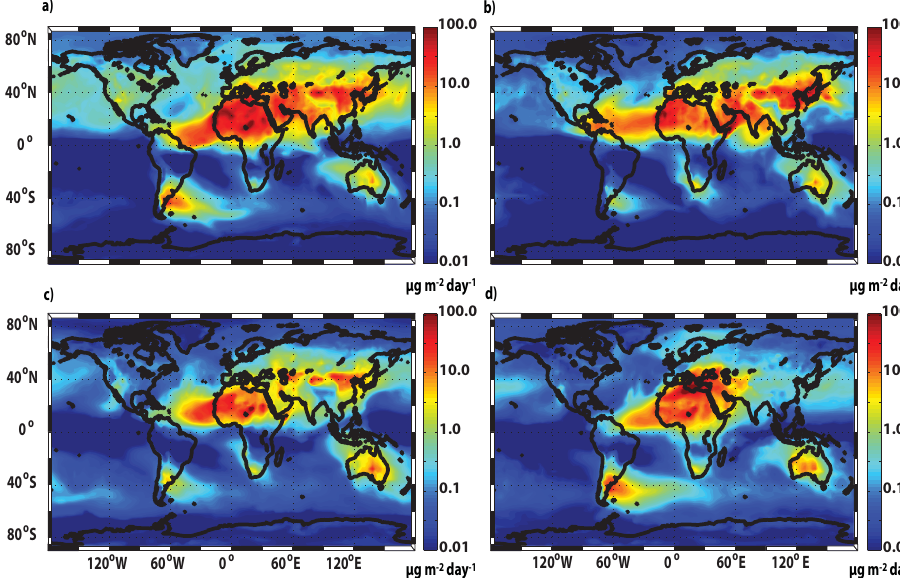
Fig. 3. Model-predicted seasonally averaged Fe d deposition rates (µgm − 2 day − 1 ) for (a) March–May (MAM), (b) June–August (JJA), (c) September–November (SON), and (d) December–February